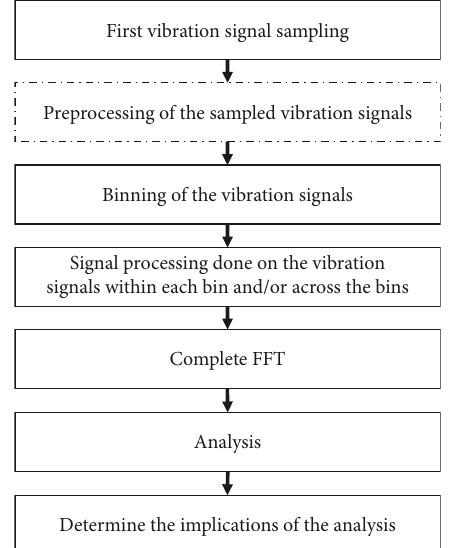
Figure 13: Signal processing flow according to the